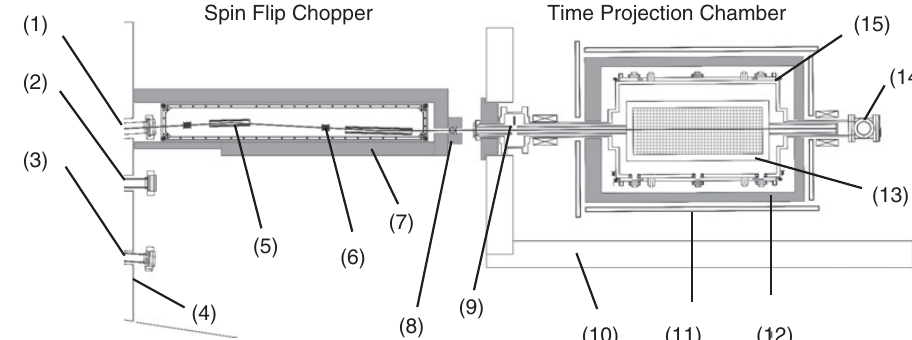
Figure 1. Schematic view of the experimental setup [11]: (1) exit of polarized beam branch, (2) exit of non-polarized beam branch, (3) exit of low-divergence beam branch of the NOP beamline, (4) lead shield, (5) magnetic super mirror, (6) radio frequency coil, (7, 8) lead shield, (9) neutron shutter (5 mm-thick 6LiF), (10) iron shield, (11) plastic scintillator, (12) lead shield, (13) TPC, (14) beam dump, (15) vacuum chamber.